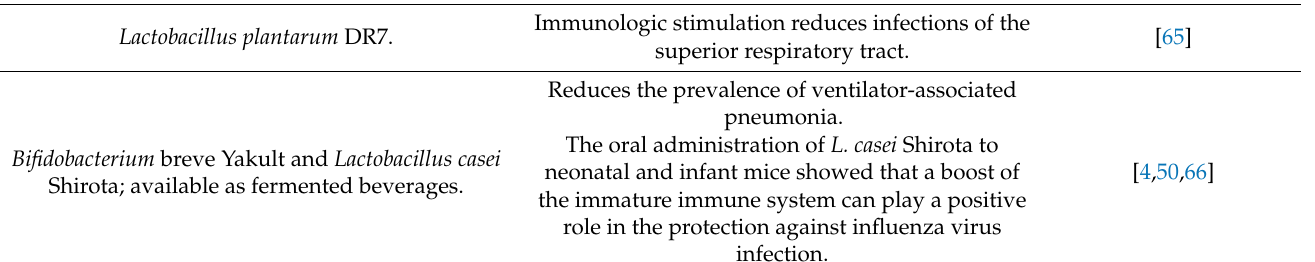
Table 1. Probiotics studied in humans that might contribute to decrease respiratory tract infection outbreaks.